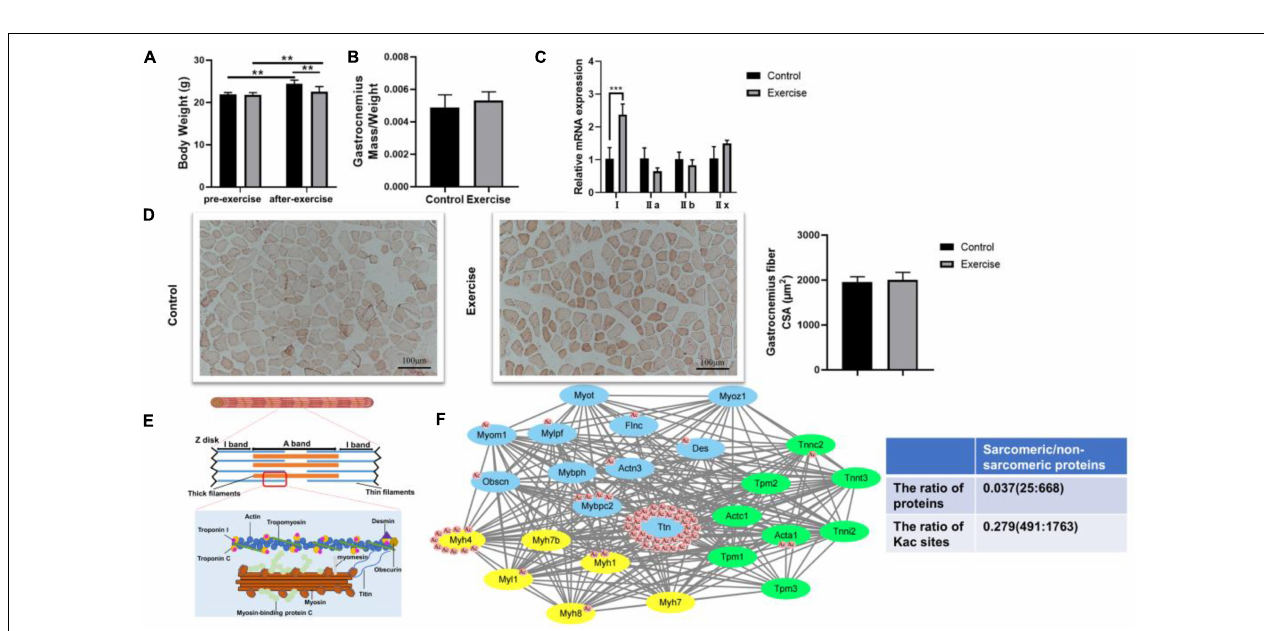
FIGURE 1 | Identification of lysine-acetylated proteins and sites in the gastrocnemius muscle. (A) Schematic of the LC/MS-based quantitative acetylproteomic strategy. (B) The basic statistical figure for MS results. (C) Distribution of acetylated proteins based on the number of acetylated peptides. (D) Comparison of our proteomic study with Lundby’s (Lundby et al., 2012). The figure shows the number of lysine-acetylated proteins and sites identified in muscle from three different species.